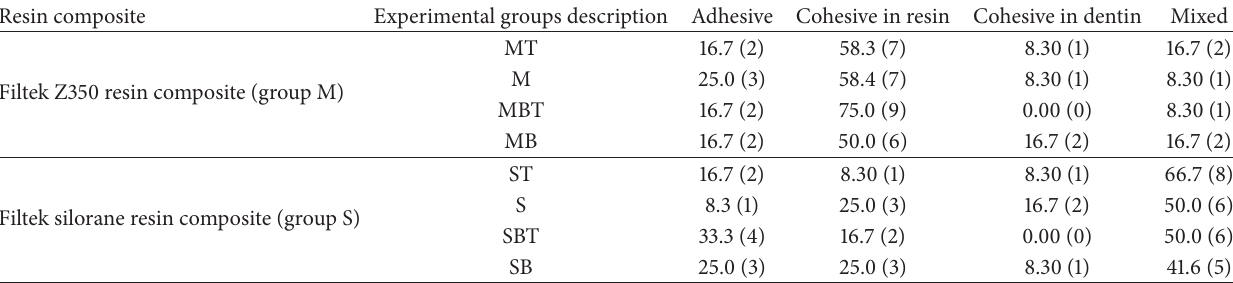
Table 3: The fracture pattern mode % ( 𝑁 ) of each experimental group. Resin